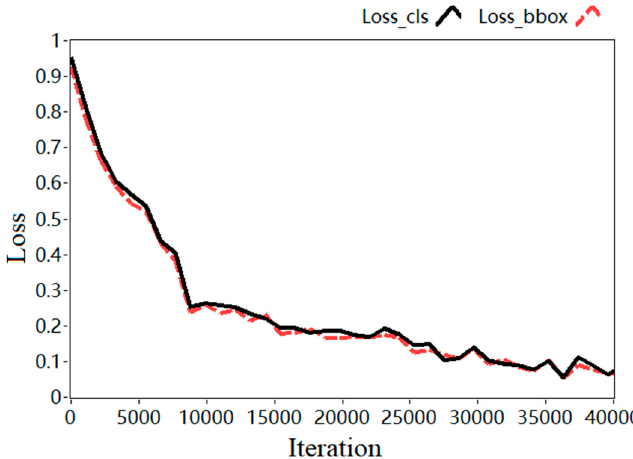
Figure 2. Training curves of MSE-Faster R-CNN.